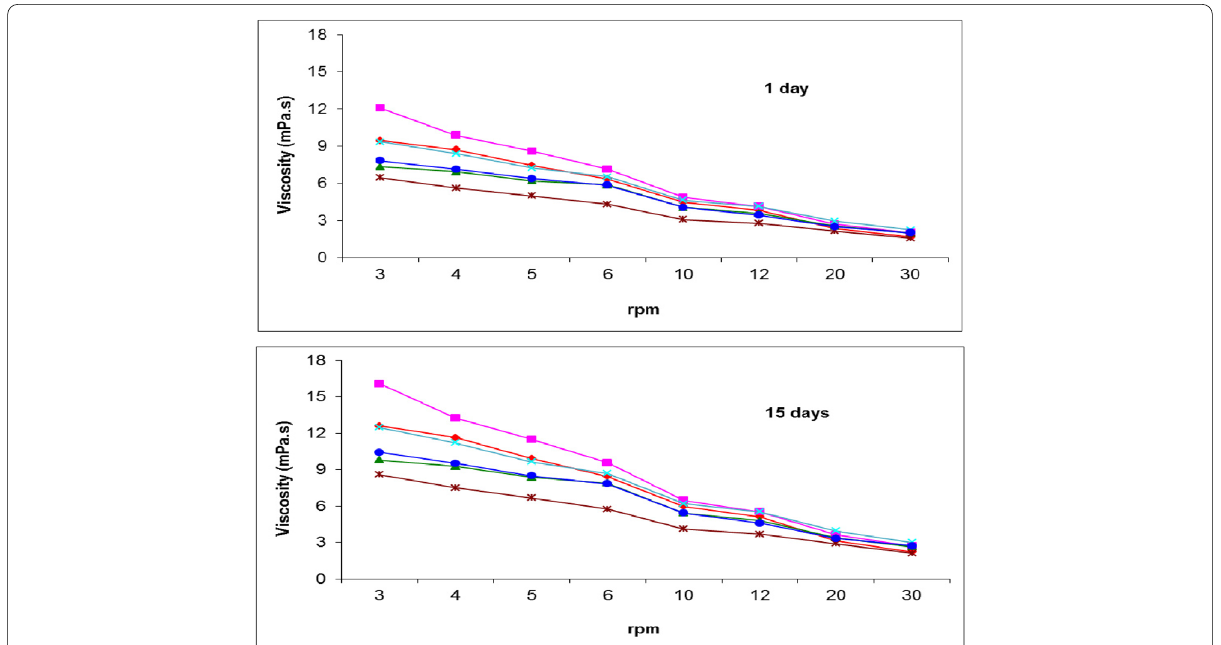
Fig. 3 Structure viscosity of probiotic and non‑probiotic yoghurt made from ewes’ milk fed a diet supplemented with Spirulina platensis or fish oil during storage at 5 2°C for 15 ±